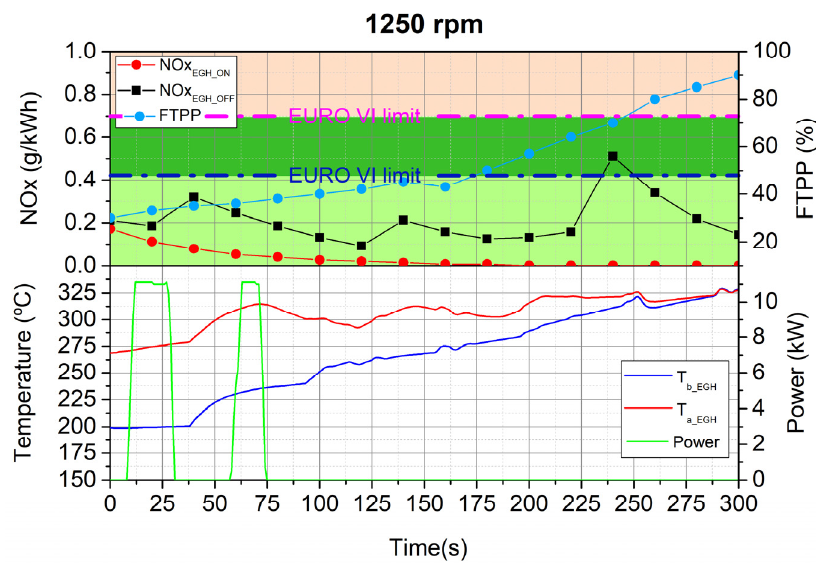
Figure 7. Results from Test 2 including NOx values, FTPP and gas temperatures at 1250 rpm. On the other side, the use of the EGH continues to be beneficial in reducing NOx emissions below EURO VII limit. NOx EGH _ ON values decreased as FTPP increased and remained around 0 g/kWh for almost the second half of the test. The main NOx reduction was performed at high FTPP values in contrast to test 1. However, they share the same drastic reduction of NOx EGH _ OFF values at 70% of FTPP that can be explained due to AdBlue injection. In this case it can be noted that, when EGH was disabled, the AdBlue injection started at 220 ◦ C approximately. When EGH was enabled, the AdBlue injection started at the beginning of the test. Apart from that, it can be observed that a higher T a _ EGH produce a higher SCR conversion and a higher NOx reduction. Both T a _ EGH and T b _ EGH temperatures converge at the end of the